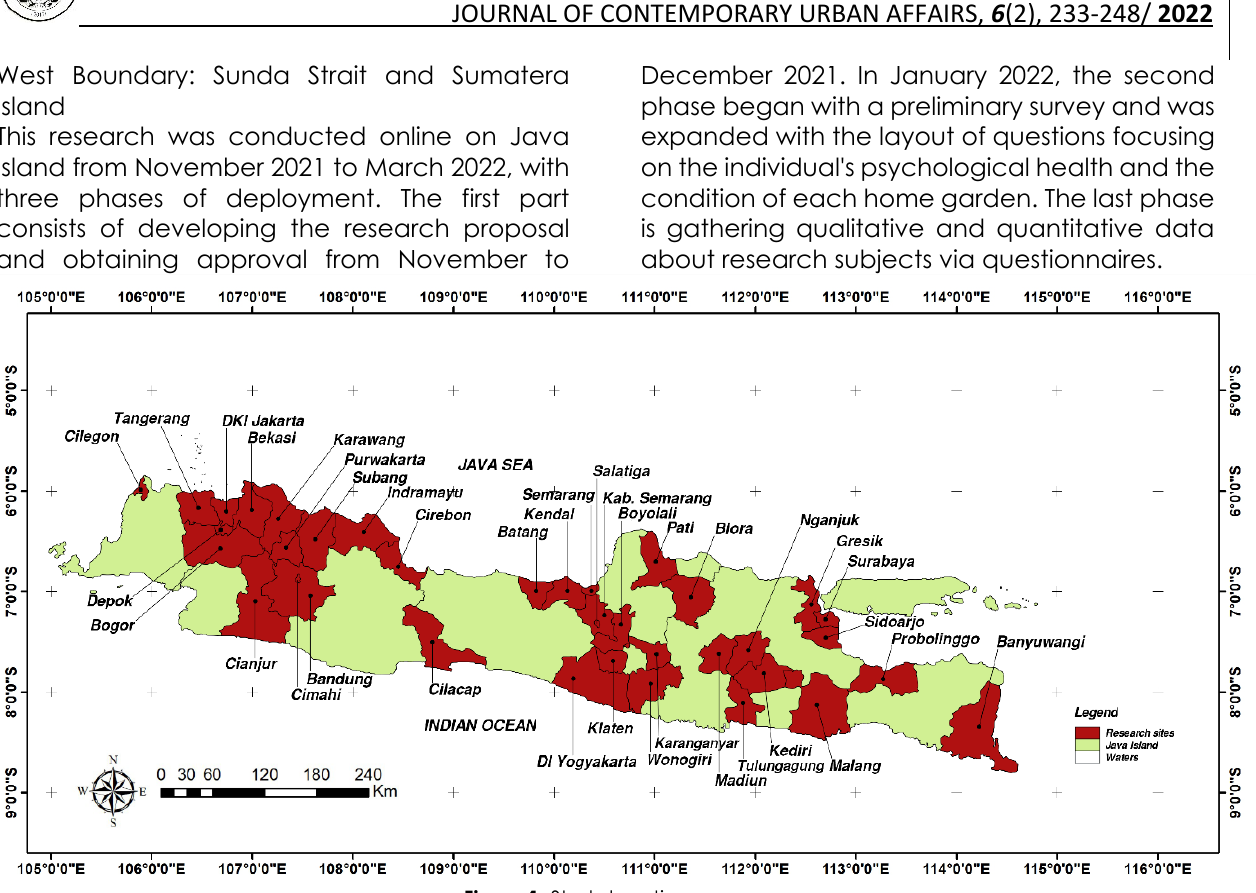
Figure 1. Study location map. Note: Banten (Cilegon, Tangerang), DKI Jakarta, West Java (Bandung, Bekasi, Bogor, Cianjur, Cimahi, Cirebon, Depok,